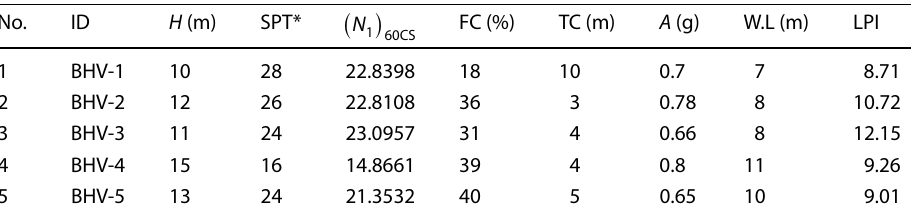
*The provided SPT is for the soil layer with a higher possibility of liquefaction (with larger SPT values), and the other parameters are related to the selected